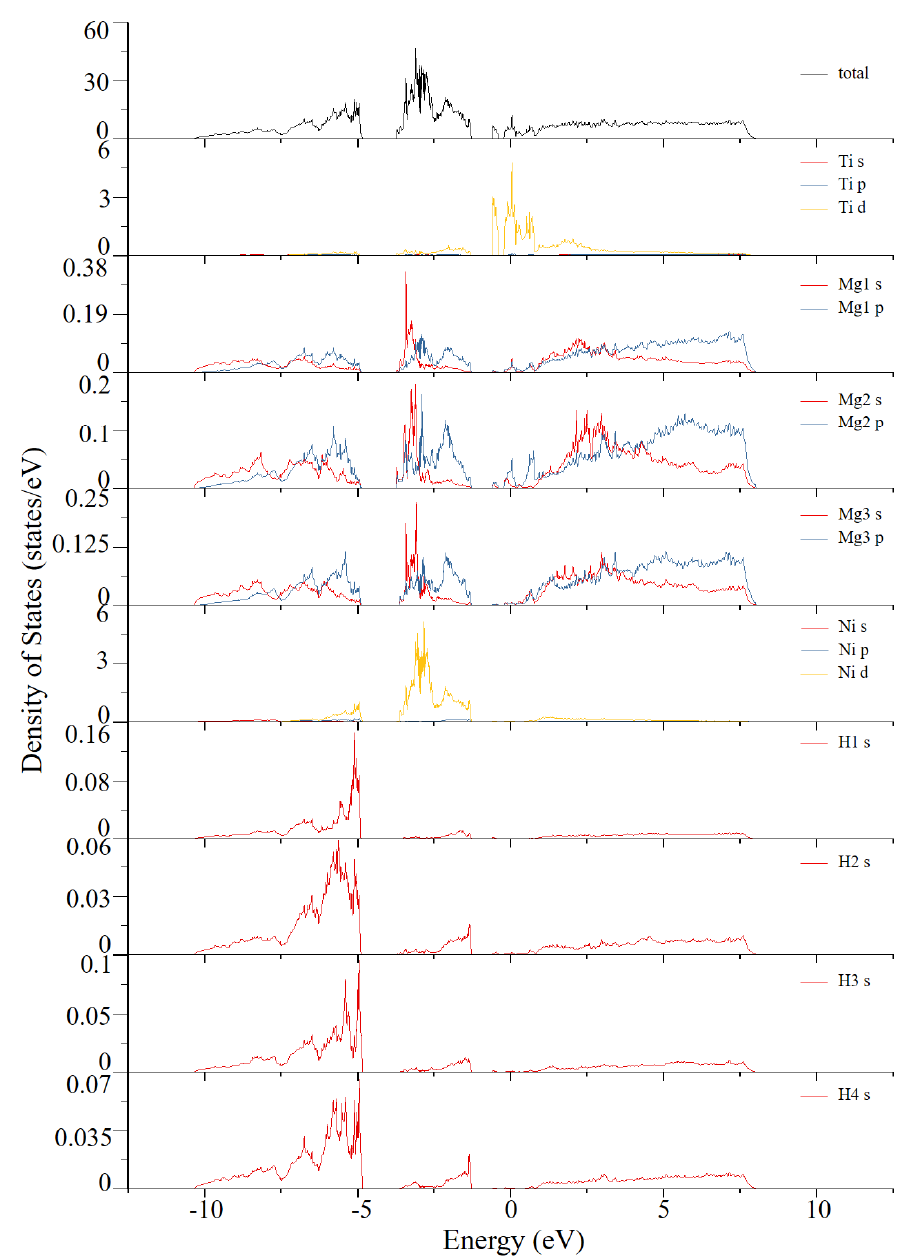
Figure 9. The calculated total and partial electronic DOS for the Ti-doped system. The Fermi level is set at zero.